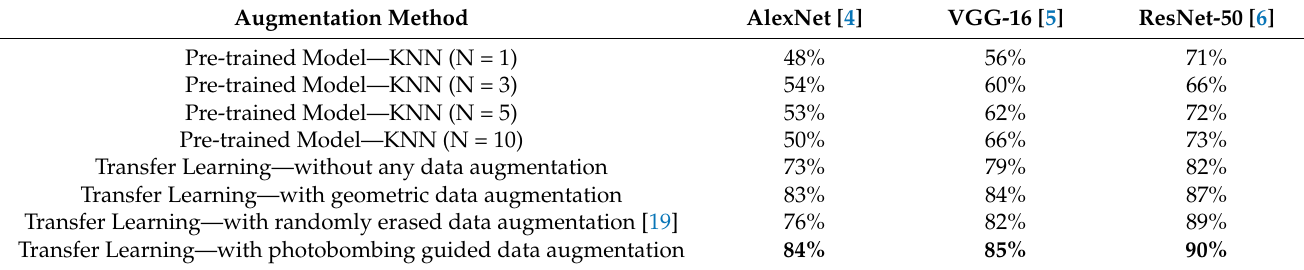
Table 1. Experimental results of different backbones and data augmentation methods. The best performance of each backbone is marked with boldface.